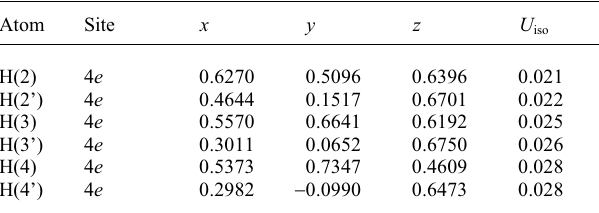
Table 2. Atomic coordinates and displacement parameters (in Å 2 ) .